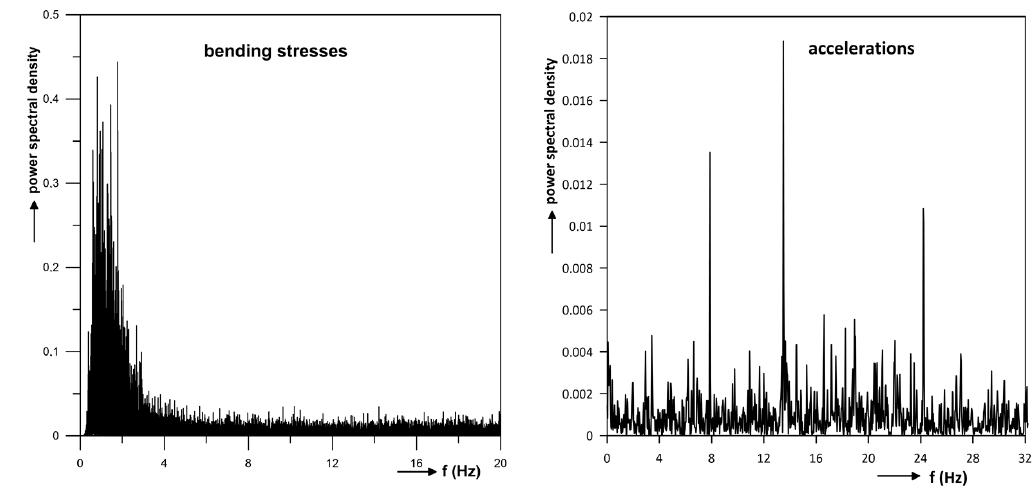
Figure 3. Frequency composition of signals measured by accelerometers and strain gauges on the vibrating pipe branch.